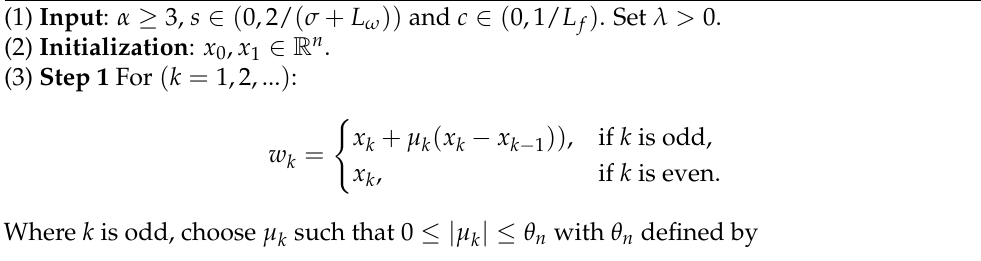
Algorithm 3 The alternated inertial Bilevel Gradient Sequential Averaging Method (aiBiG-